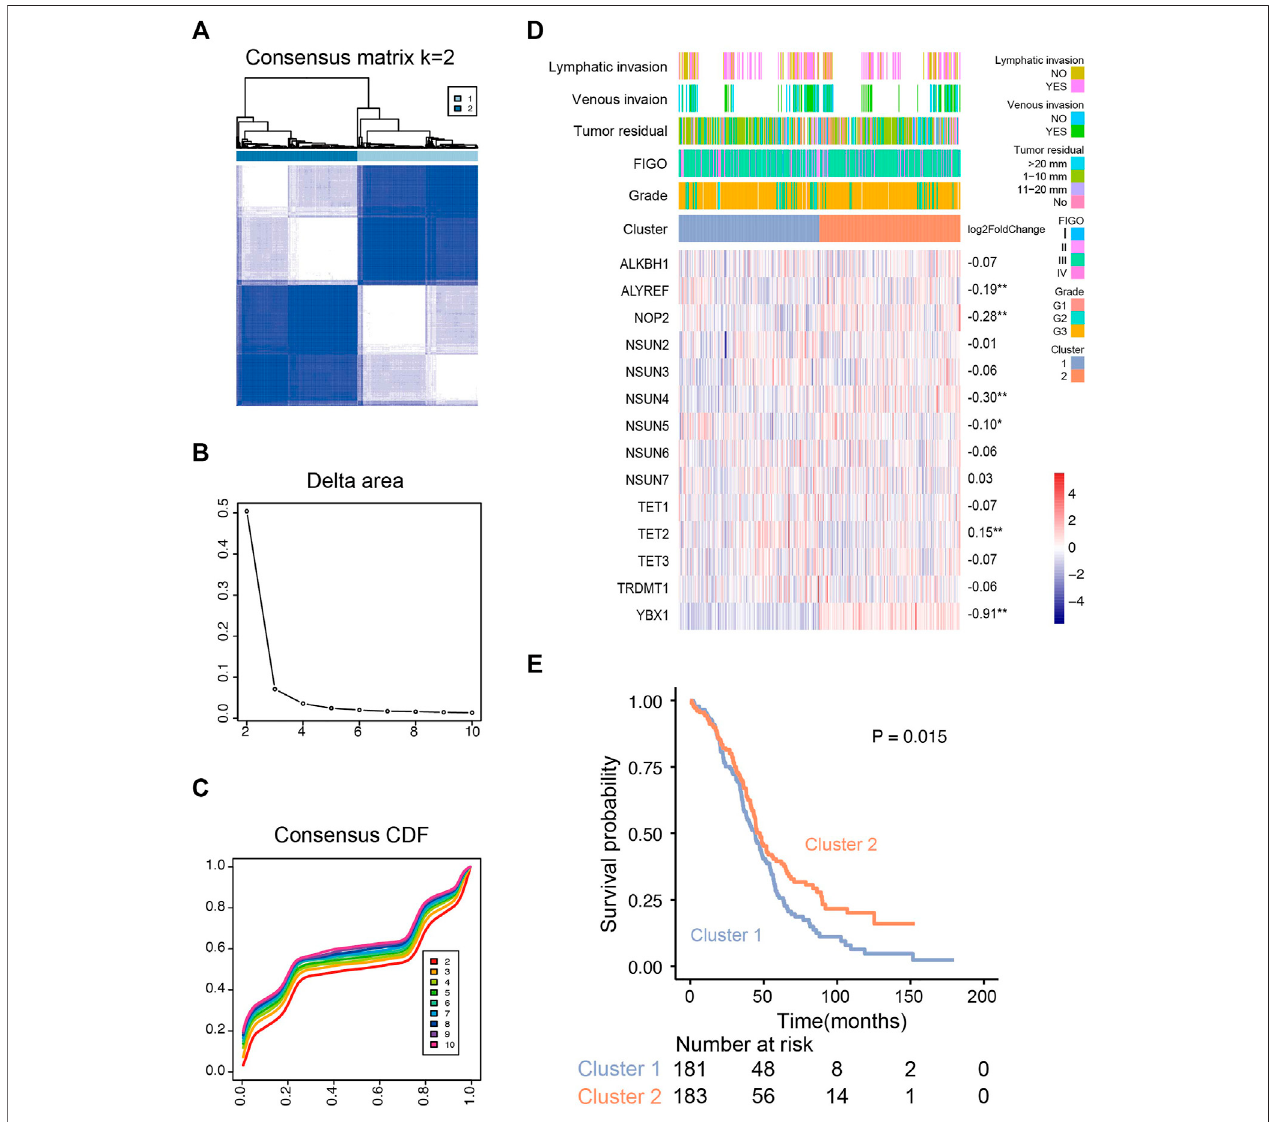
FIGURE 3 | Unsupervised consensus clustering analysis of RNA m 5 C regulators. (A) Consensus clustering matrix for the most suitable k (k = 2). (B) Relative changes in the area under the clustering cumulative function (CDF) curve at k = 2 – 10. (C) Consensus clustering CDF for k = 2 – 10. (D) The m 5 C regulator expression pro fi les and clinicopathological characteristics in two clusters. (E) Kaplan – Meier overall survival curves for ovarian cancer patients of two clusters in the TCGA cohort.